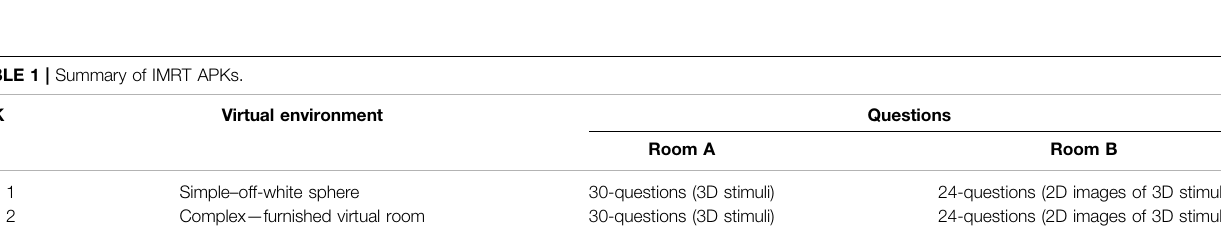
TABLE 1 | Summary of IMRT